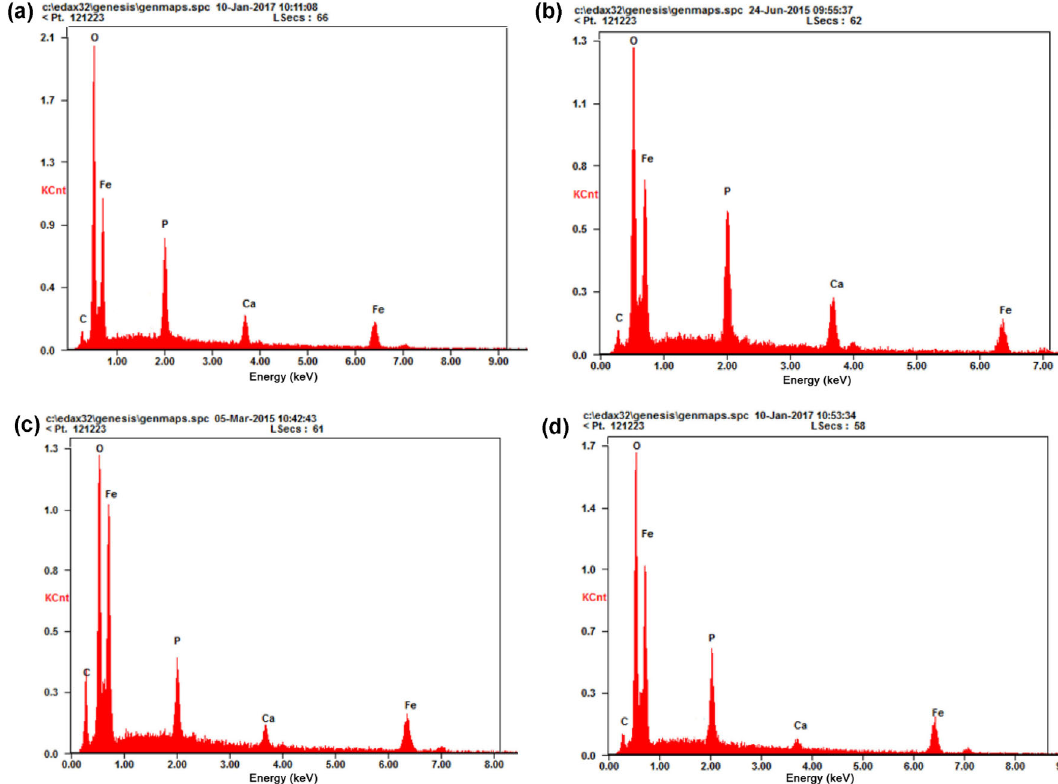
Fig. 7 EDX spectra of tribofilms on steel disc surfaces after 24 h Wazau durability tests: (a) ATF-A, (b) ATF-B, (c) ATF-C, and (d)